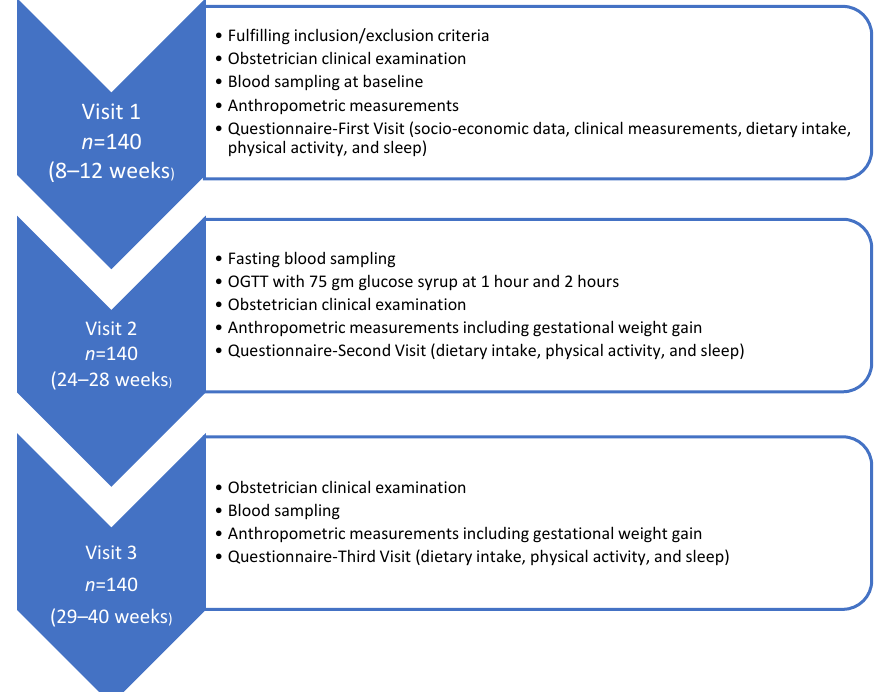
Figure 1. Flow chart of data collection across time.